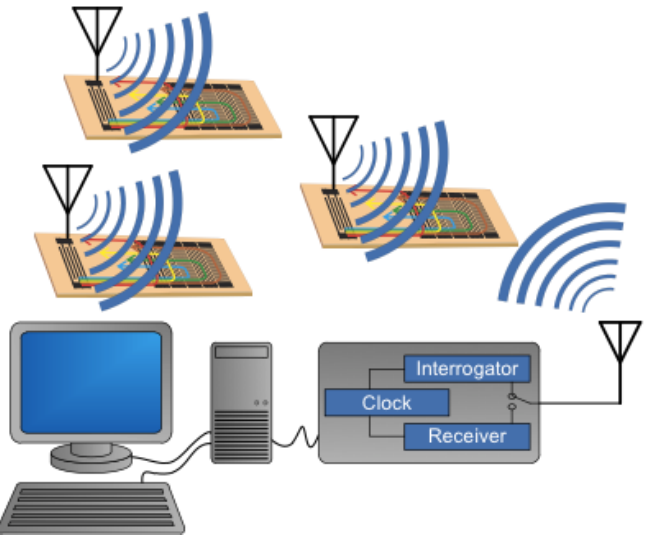
Figure 4. Schematic of a SAW wireless sensor system that will interrogate multiple sensors simultaneously. Receiving and identifying the RFID, the sensor information can be obtained via post processing of the received